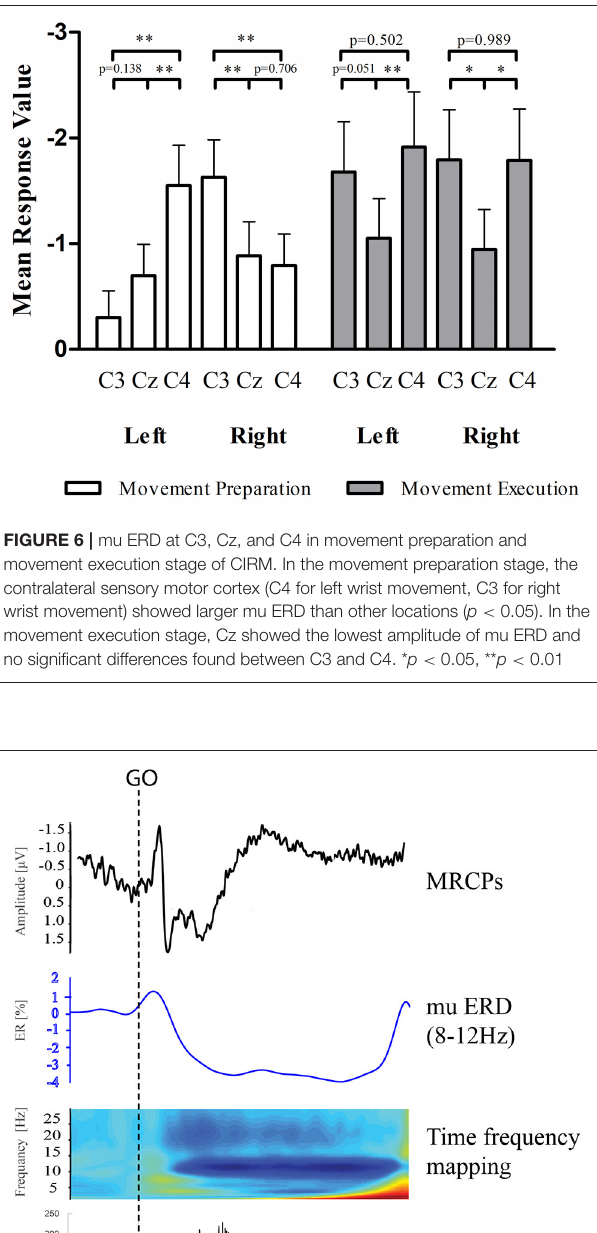
( Figure 2 ). The visual cue containing information relevant to the movement might combine the sensory stimuli responses with sensorimotor area and facilitate movement initiation. The effects of external cues were observed in previous studies and